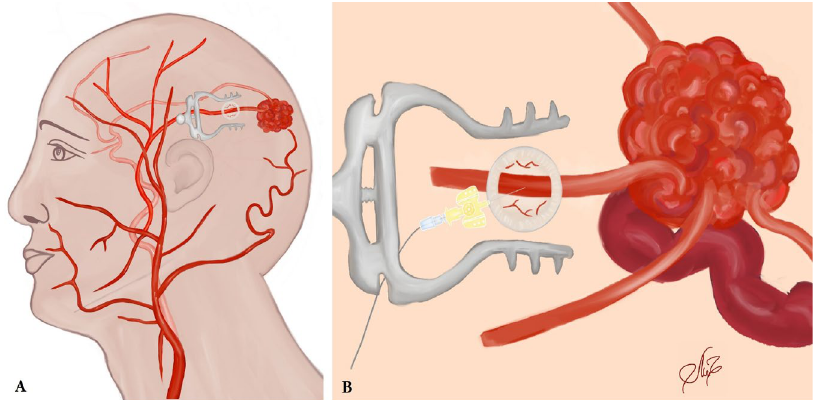
Figure 4. ( A ) An illustration of the arteriovenous malformation (AVM) with its afferent connections and the occipital craniotomy. ( B ) An illustration is provided to demonstrate the afferent puncture of the middle meningeal artery through the occipital craniotomy.